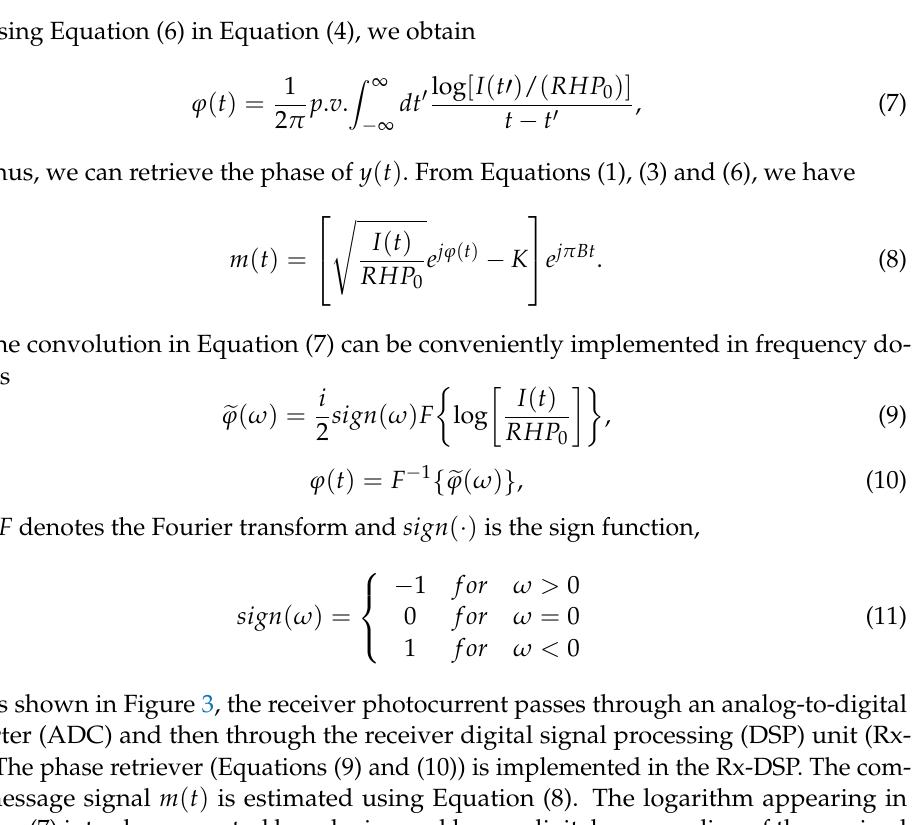
Figure 3. Schematic of the KK transceiver for FSO communications.